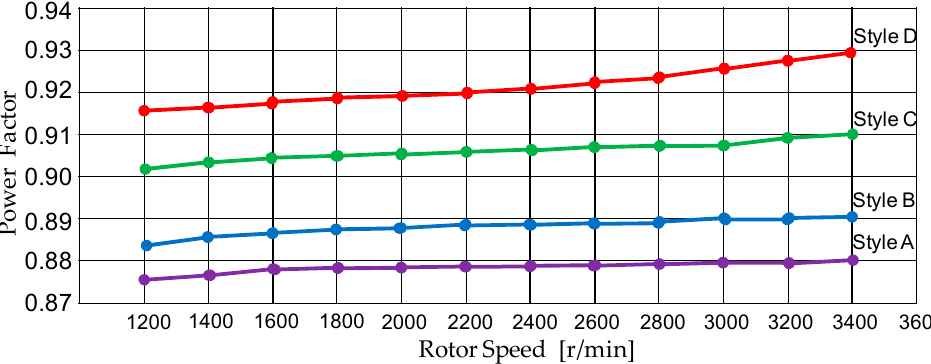
Figure 10. Poly-line graph of efficiency for four kinds of SCSCRIMs under several speeds.